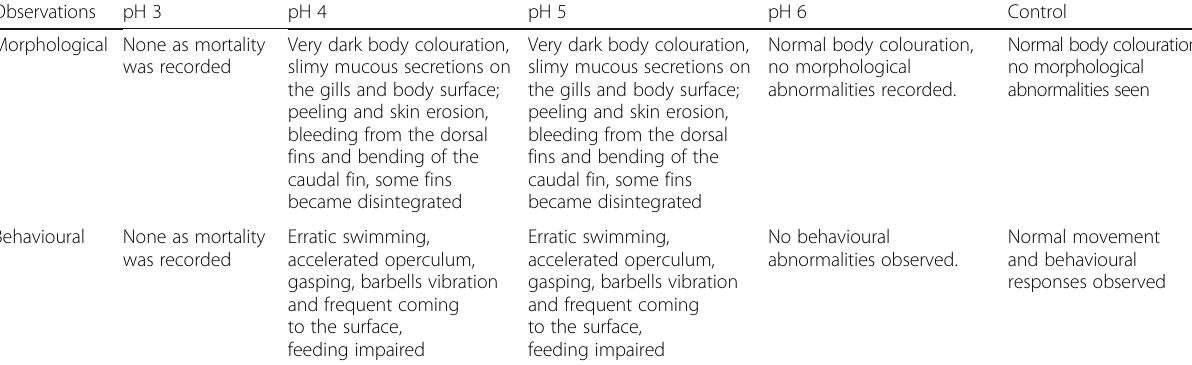
Table 6 Morphological and behavioural observations of adult of O. niloticus in low pH and control